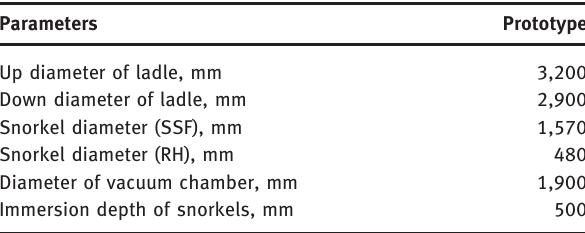
Table 1: Dimensions of SSF and RH degasser. Parameters